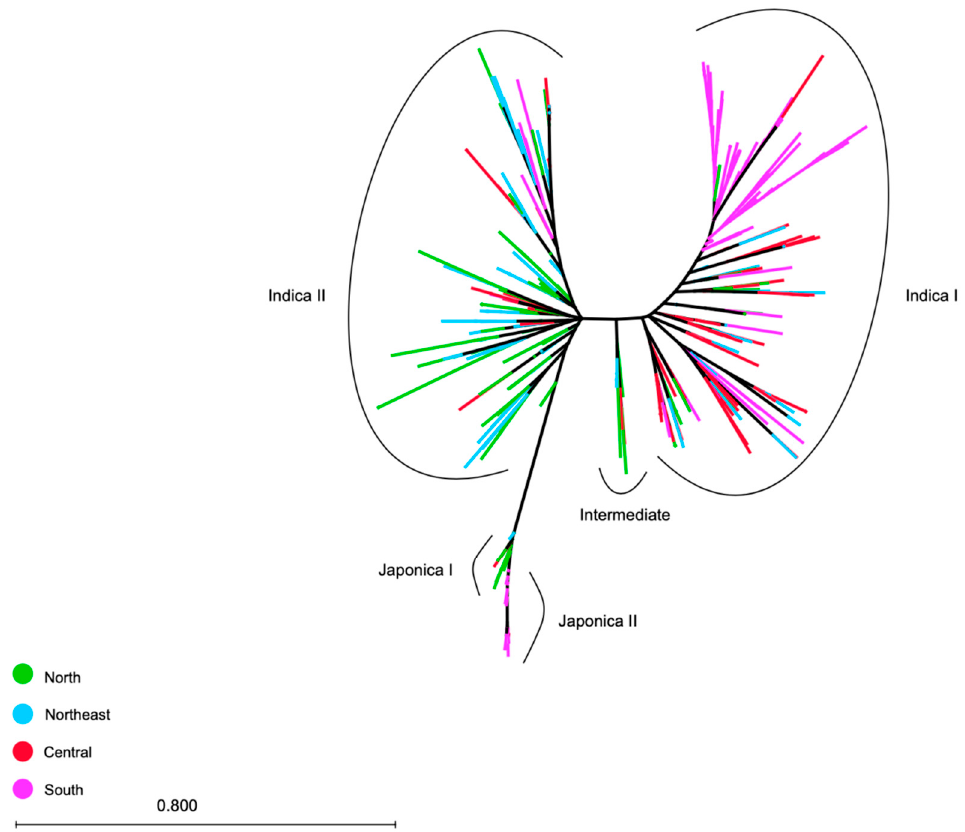
Figure 6. Maximum-likelihood dendrogram illustrating the genetic relationship among the 365 landrace accessions using four-region population partitioning.